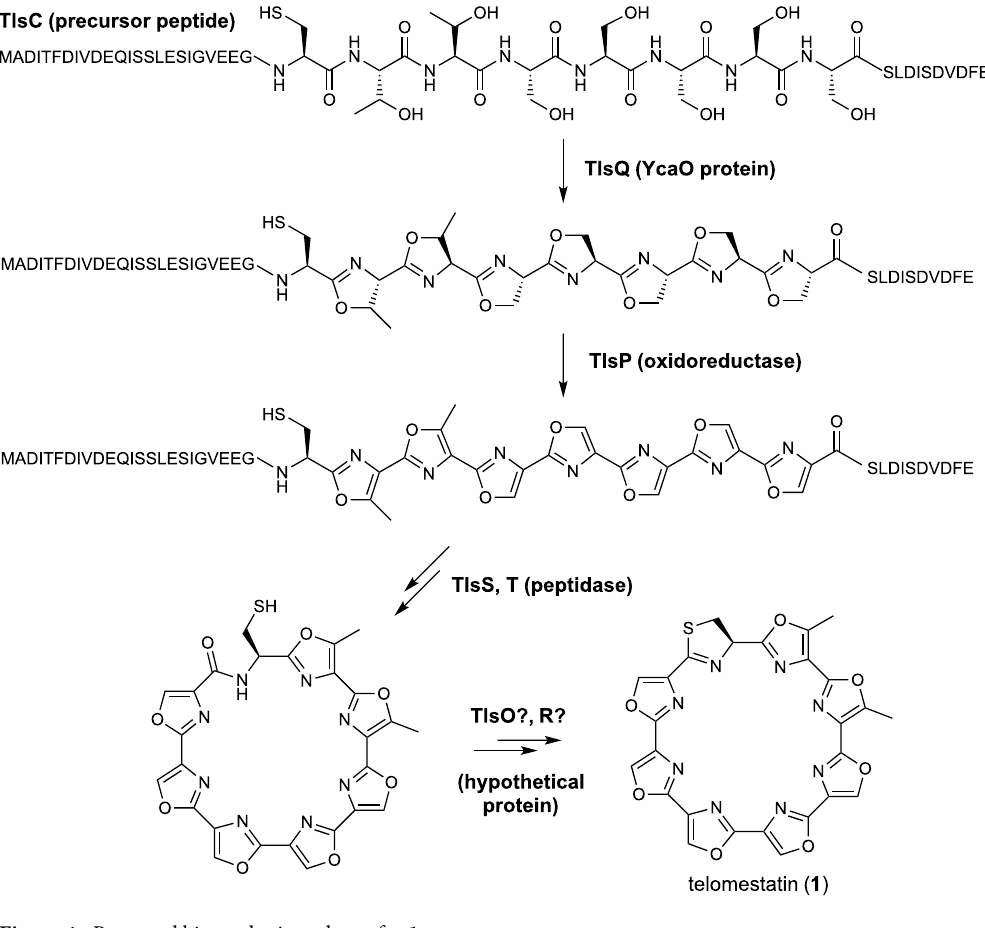
Figure 4. Proposed biosynthetic pathway for 1